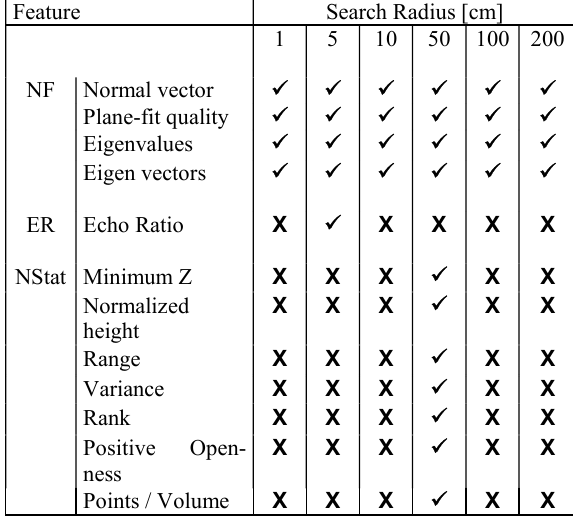
Table 2. Features extracted for different search